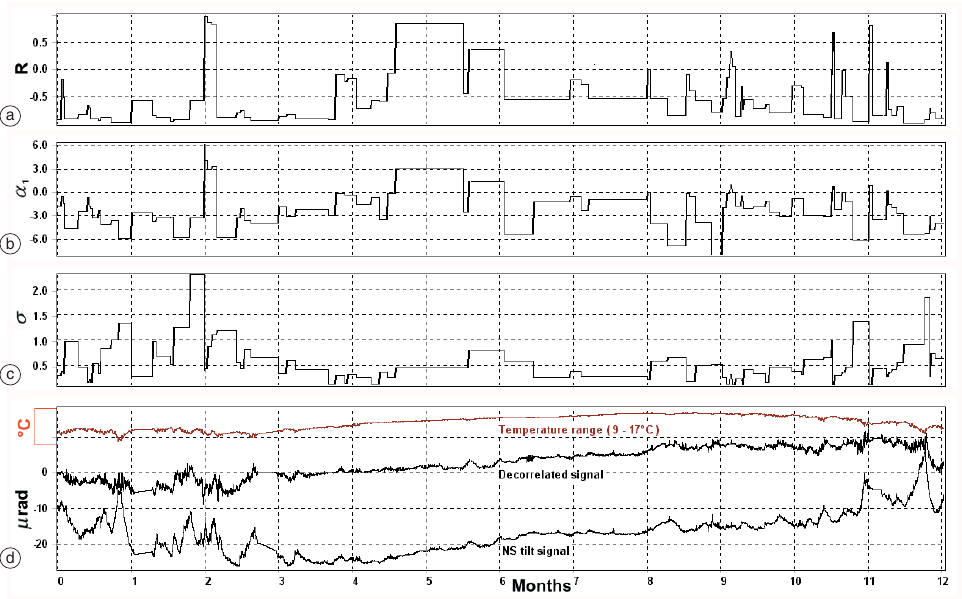
Fig. 13a-d. Application of a statistical procedure of thermal decorrelation to the NS component of the tilt recorded by DMB in 2000 through a linear dependence model. In (a), (b) and (c) the correlation coefficients, the regression coefficients ( µ rad/°C) and the standard errors of the estimate ( µ rad/ n 2- ) are displayed, respec- tively. The corrected signal (d) shows an inclination towards N (ground